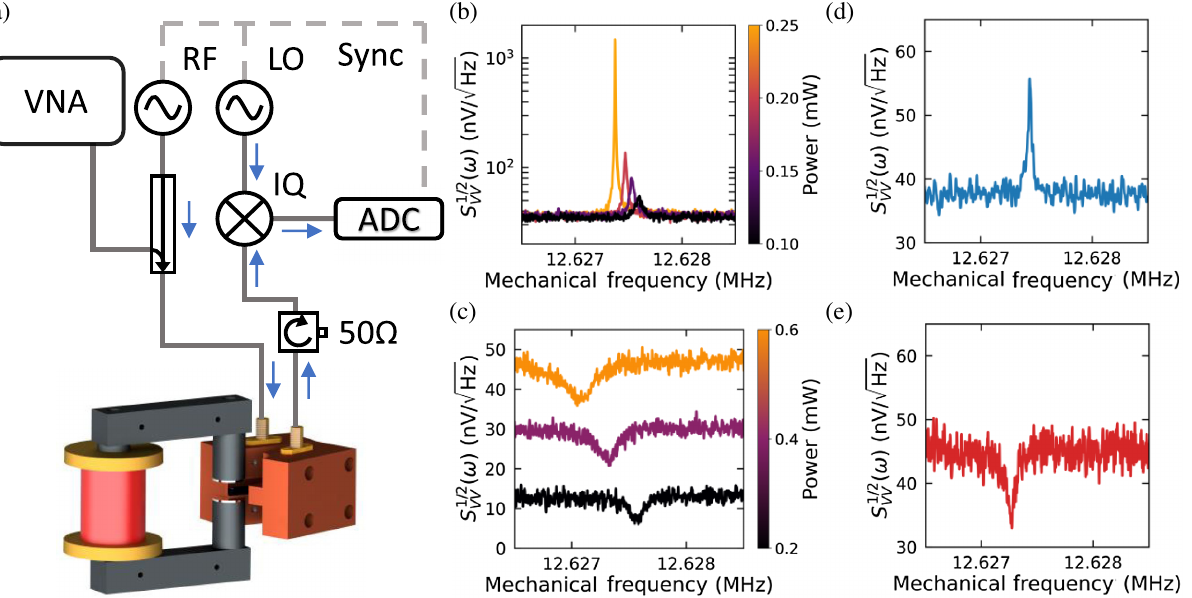
FIG. 3. Homodyne mechanical detection. (a) Simplified schematic of the measurement setup: VNA, vector network analyzer; RF and LO, microwave generators; ADC, analog-to-digital converter; IQ, IQ mixer, both the in-phase and quadrature ports were connected to the ADC. (b) Power spectral density of the mechanical motion. The normal mode spectrum was tuned to Fig. 2(d). The probe was tuned directly on resonance with the upper normal mode. With increasing drive power, a frequency shift and linewidth narrowing can be observed. (c) Power spectral density of the mechanical motion, offset for clarity. The normal mode spectrum was tuned to Fig. 2(c). The probe was tuned directly on resonance with the lower normal mode. Because of interference between scattered excitations and the thermal magnon bath, the power spectrum lies below the noise floor, known as noise squashing. (d) Power spectral density of the mechanical motion, the drive tone was detuned one mechanical frequency above the upper normal mode. (e) Power spectral density of the mechanical motion, the drive tone was detuned one mechanical frequency below the lower normal mode. For both (d) and (e), the drive power was held constant at 12 mW. All data presented were obtained with the experimental setup in a partial pressure of helium